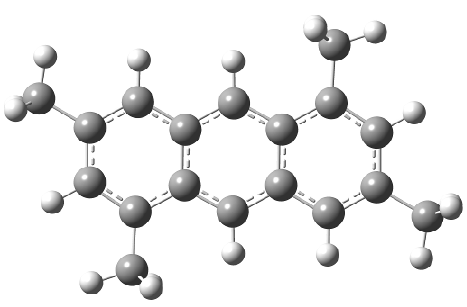
Figure 6. Structure of compound 4